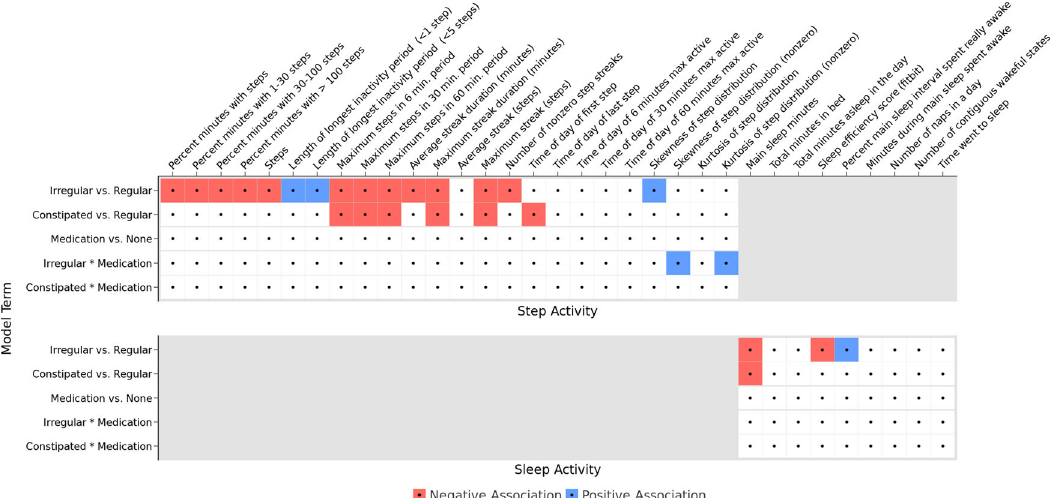
Fig. 2 Regression model results for steps and activity features. Overview of the regression model results for the fi ve different comparisons of bowel movement or medication use patterns to steps and sleep activity features. Signi fi cant results are shown in color, with red denoting a negative association and blue denoting a positive association. Among the models for heart rate features (not shown) signi fi cant associations were only observed for 95th percentile heart rate, which was negatively associated with both irregular and constipated